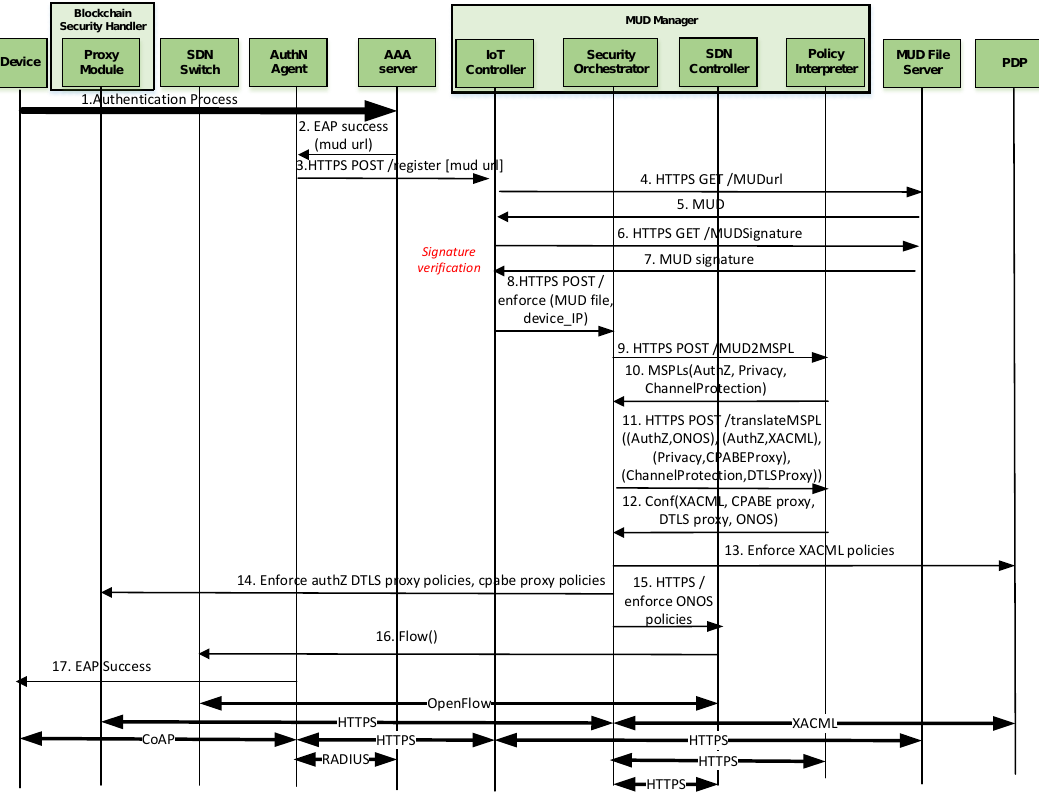
Figure 2. Message exchange of the bootstrapping